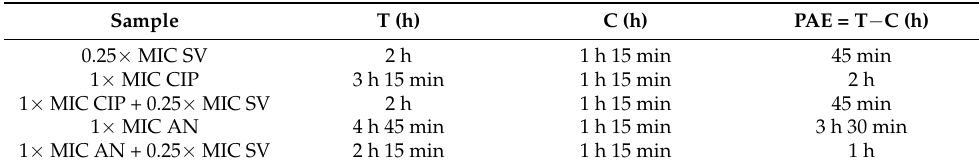
Figure 5. PAE of amikacin (AN) against E. coli in the presence of S. virgaurea extract (SV). Table 2. PAE of ciprofloxacin (CIP) and amikacin (AN) against E. coli in the presence S . virgaurea extract (SV).